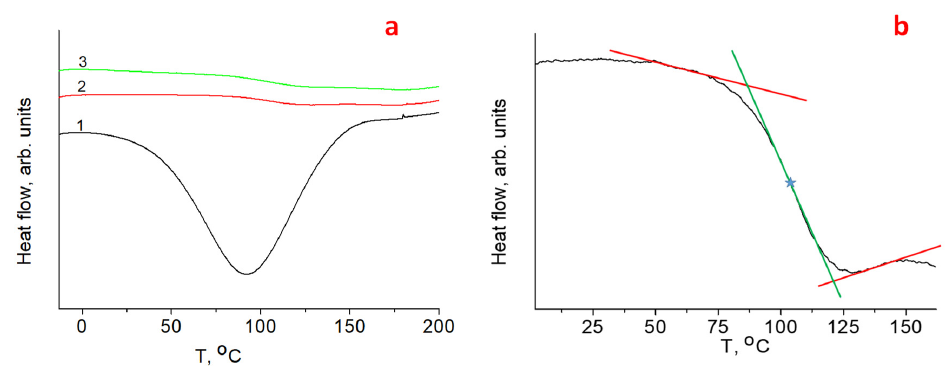
Figure 4. ( a )—DSC curves for HogC cellulose (curve 1—the first heating of the HogC sample from − 10 to +200 ◦ C; curve 2—the second heating of the HogC sample from − 10 to +200 ◦ C; curve 3—the third heating of the HogC sample from − 10 to +200 ◦ C); ( b )—illustration of the determination process for Tg